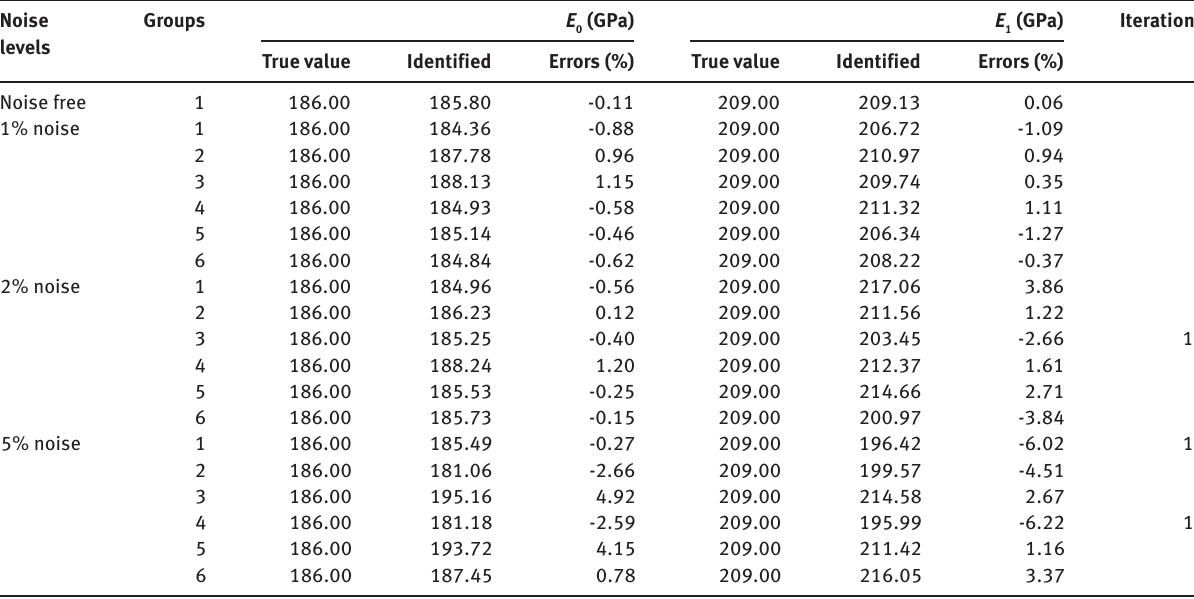
Table 15: Identified parameters of a rectangular FGM plane structure with exponential material variation (case 4: initial value E = 105 E 1